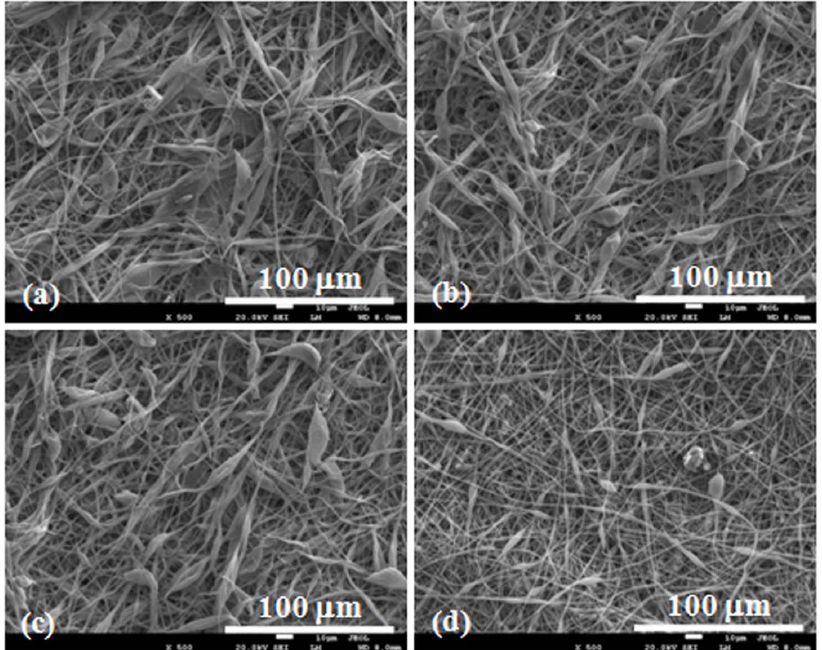
Figure 6. SEM images of HSFs growth on the electrospun fibrous scaffolds after 9 d culture. (a) PLLA fibers, (b) PLLA-2%, (c) PLLA-6% and (d) PLLA-10%.